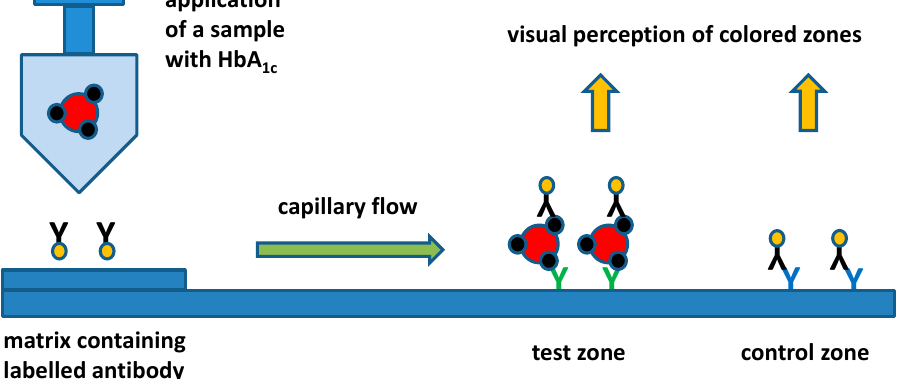
Figure 3. General principle of lateral flow test for HbA 1c assay.